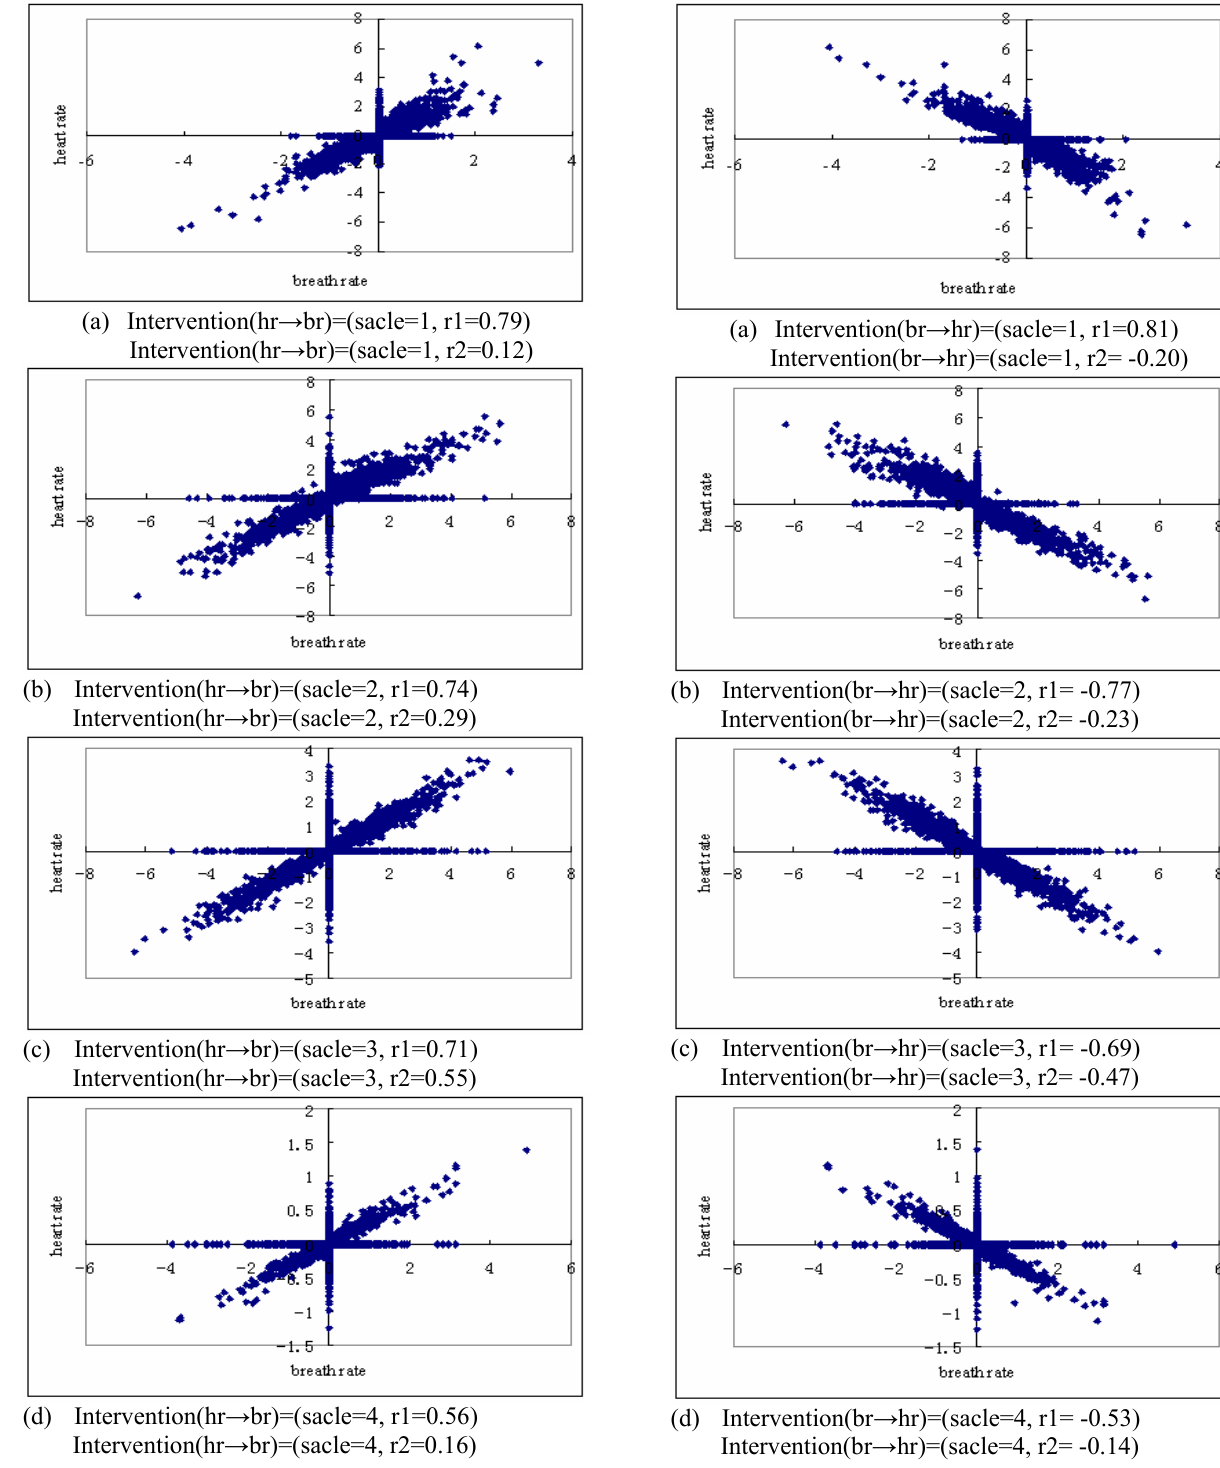
Fig. 6. Intervention rules from heart rate to breath rate Fig. 7. Intervention rules from breath rate to heart